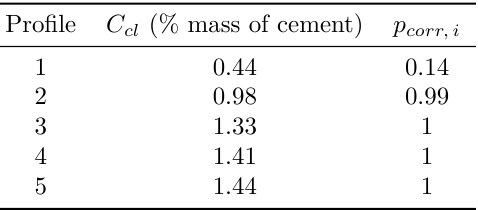
Table 1. Chloride contents at the depth c = 22 . 5 mm and calculated values of p corr,i .